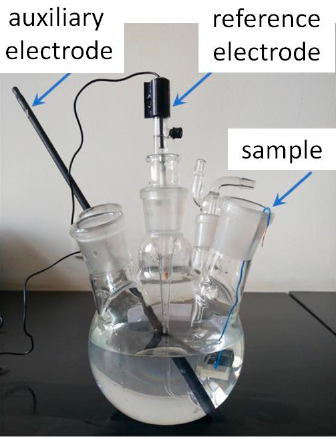
Figure 5. Schema of the experimental set up for the resistance of pitting corrosion.